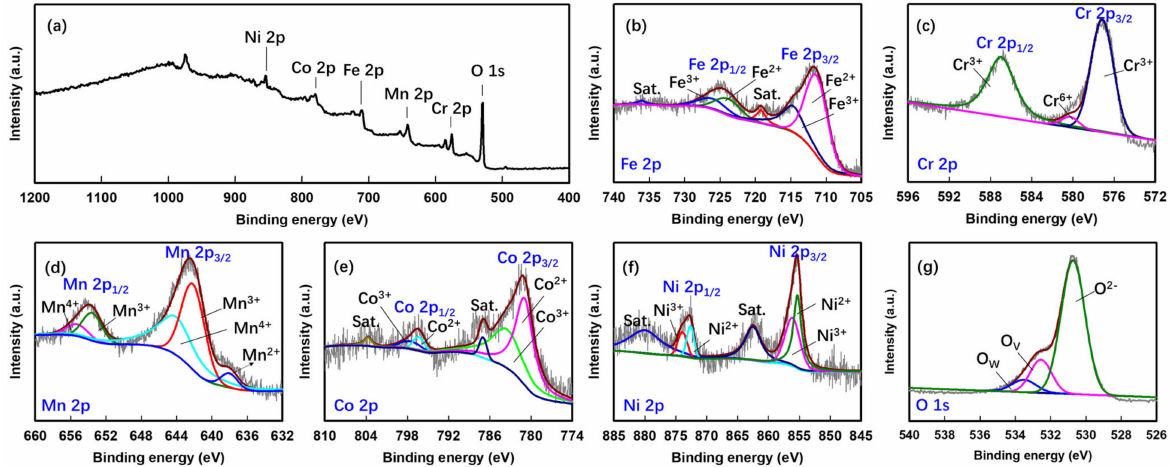
Figure 5. ( a ) XPS survey spectra for the proposed HEMO3 material. High-resolution XPS spectra for ( b ) Fe 2 p , ( c ) Cr 2 p , ( d ) Mn 2 p , ( e ) Co 2 p , ( f ) Ni 2 p , and ( g ) O 1 s for HEMO3.